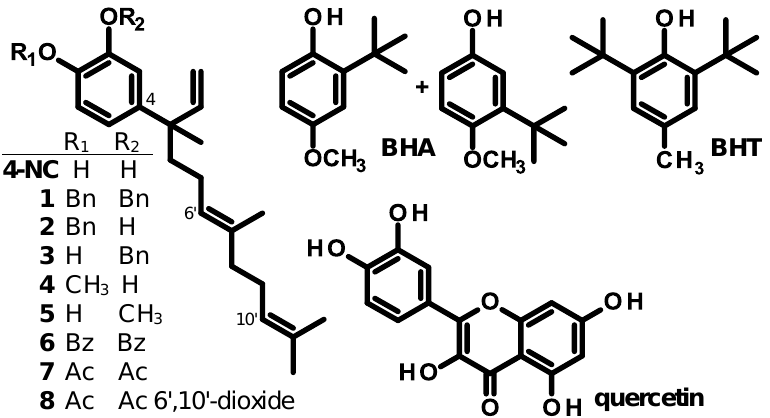
Figure 1. Structures of 4-NC (4-nerolidylcatechol), semi-synthetic derivatives of 4-NC 1 – 8 and synthetic food additives BHA (butylated hydroxyanisole) and BHT (butylated hydroxytoluene) and the flavonoid